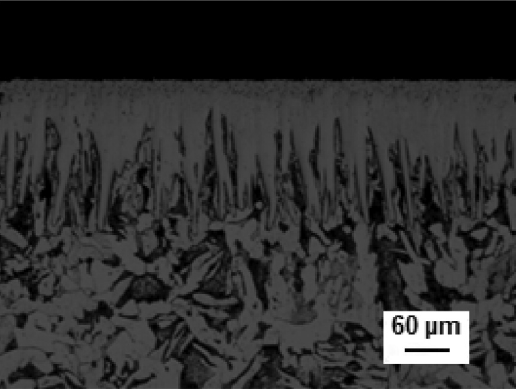
An iso-diagram thickness was also plotted as a func- tion of the temperature and exposure time as shown in Figure 12. This contour plot can be used as a powerful tool to select the optimum value of Fe B layer thickness in rela- 2 tion with the potential applications of the borided AISI 1026 steel for industrial applications.